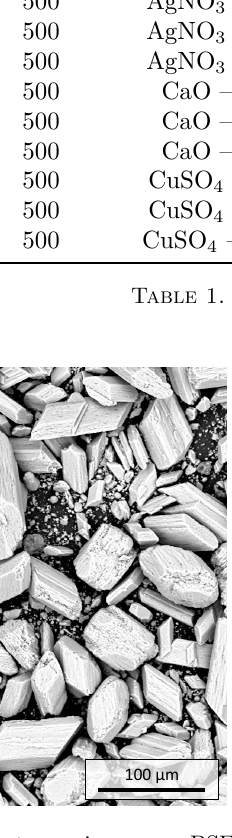
Figure 2. Sample placed on agar in petri dish after 41